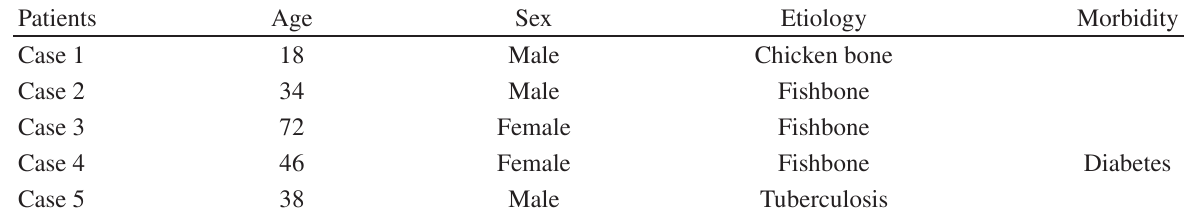
FIGURE 6: Disappearance of the retropharyngeal collection after treatment. TABLE 1: Summary of epidemiological data and suspected etiologies.